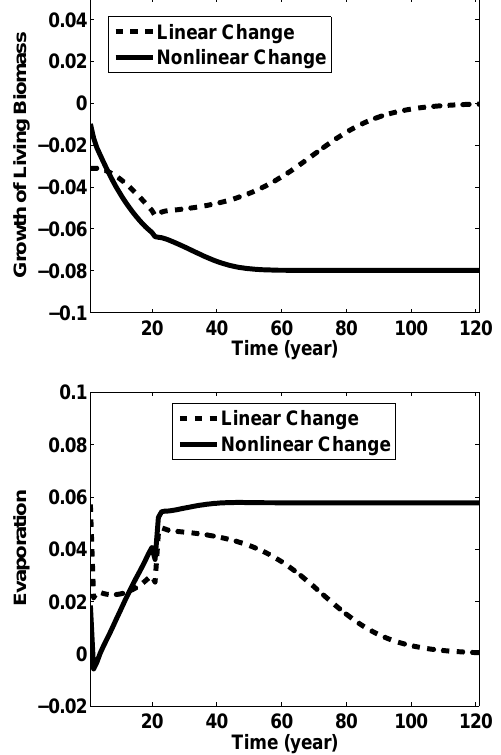
Fig. 5. The variations of the growth of living biomass G and the evaporation from soil surface shaded by the wilted biomass E s caused by different types human activities and climate change when δ 1 = 0 . 3 and δ 2 = 0 . 22. The growth of living biomass (top), and the evaporation